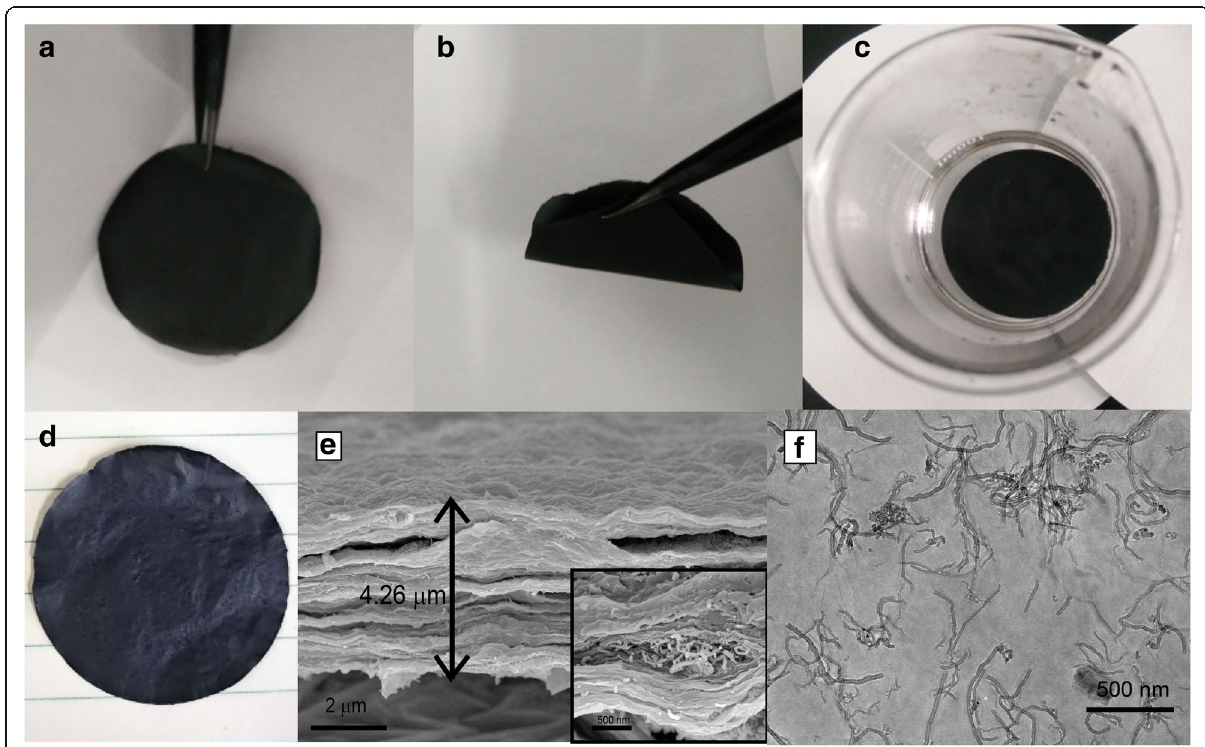
Fig. 2 Optical images of PDDA-MWCNTs/GO membrane ( a ), the flexibility of the membrane ( b ), and the stability of membrane in water ( c ). Membrane which had been filtrated for more than 8 cycles ( d ). e SEM images of cross-sections of the PDDA-MWCNTs/GO membrane (thickness 4.26 μ m). The inset shows a higher magnification image of the PDDA-MWCNTs/GO membrane. f TEM images of the ;PDDA-MWCNTs/GO